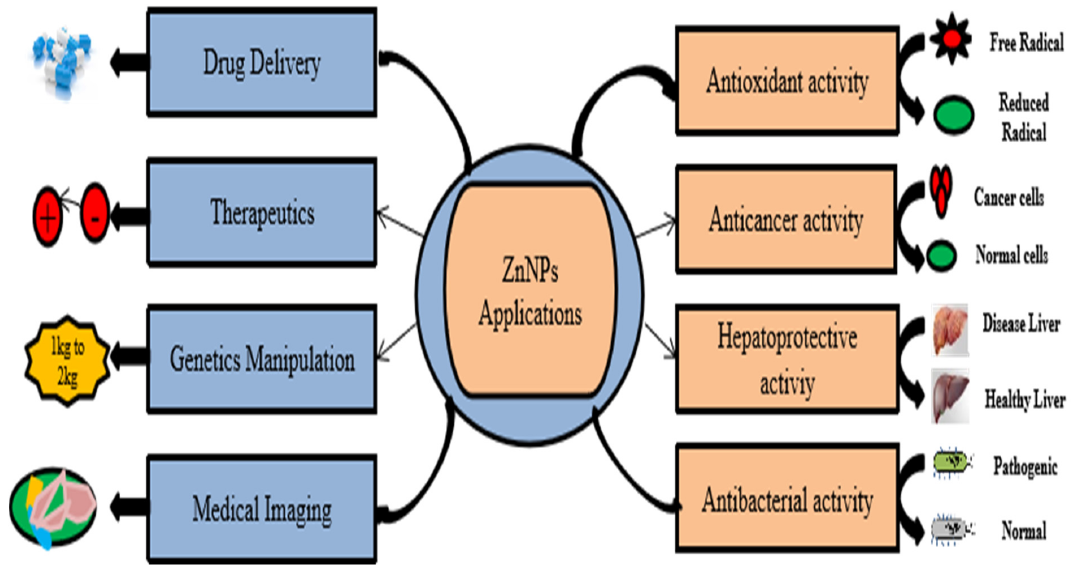
Figure 2. Application of Zinc nanoparticles on health performance of broilers. Antioxidant activity (Zn NPs responsible for conversion of free radical to reduced radical), anticancer activity (cease or slow production of diseased cells), hepatoprotective activity (diseased liver to healthy liver), anti ‐ bacterial activity (against bacterial infections), targeted drug delivery in dose ‐ dependent manner, genetic manipulation (boosting body weight), and medical imaging (to obtain a pectoral view of targeted cell or animal tissues).